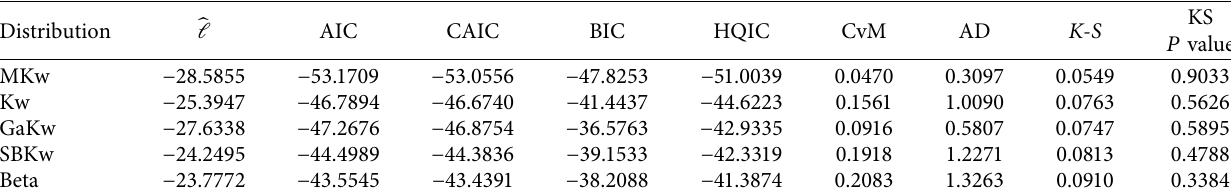
Table 14: Te statistics AIC, CAIC, BIC, HQIC, CvM, AD, and K - S for data set 3.